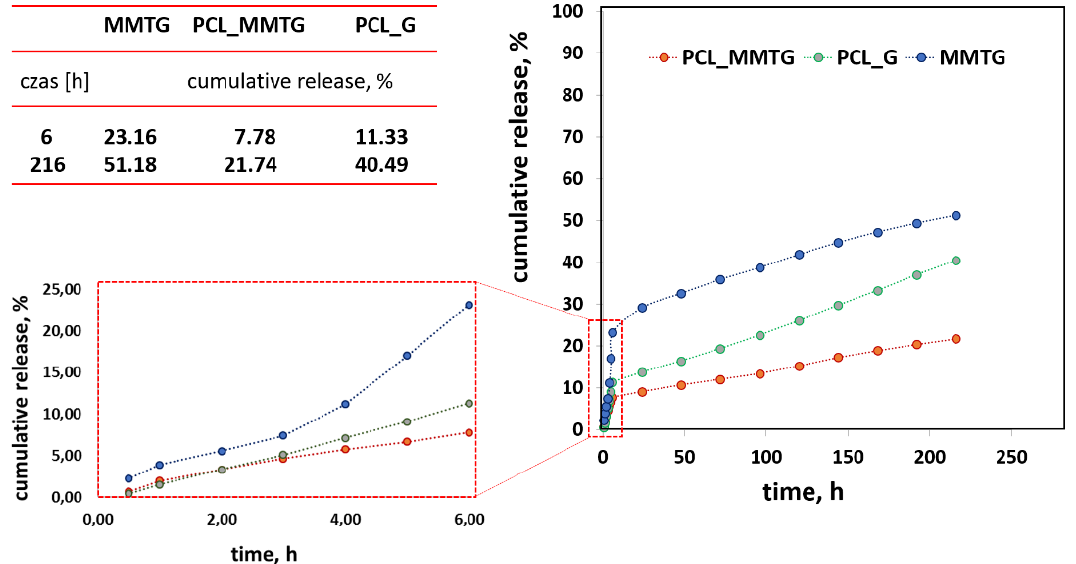
Figure 8. The rate of antibiotic release from the MMTG powder and PCL_MMTG and PCL_G materials during a 216 h in vitro study in PBS of pH=7.4 at 37 °C.